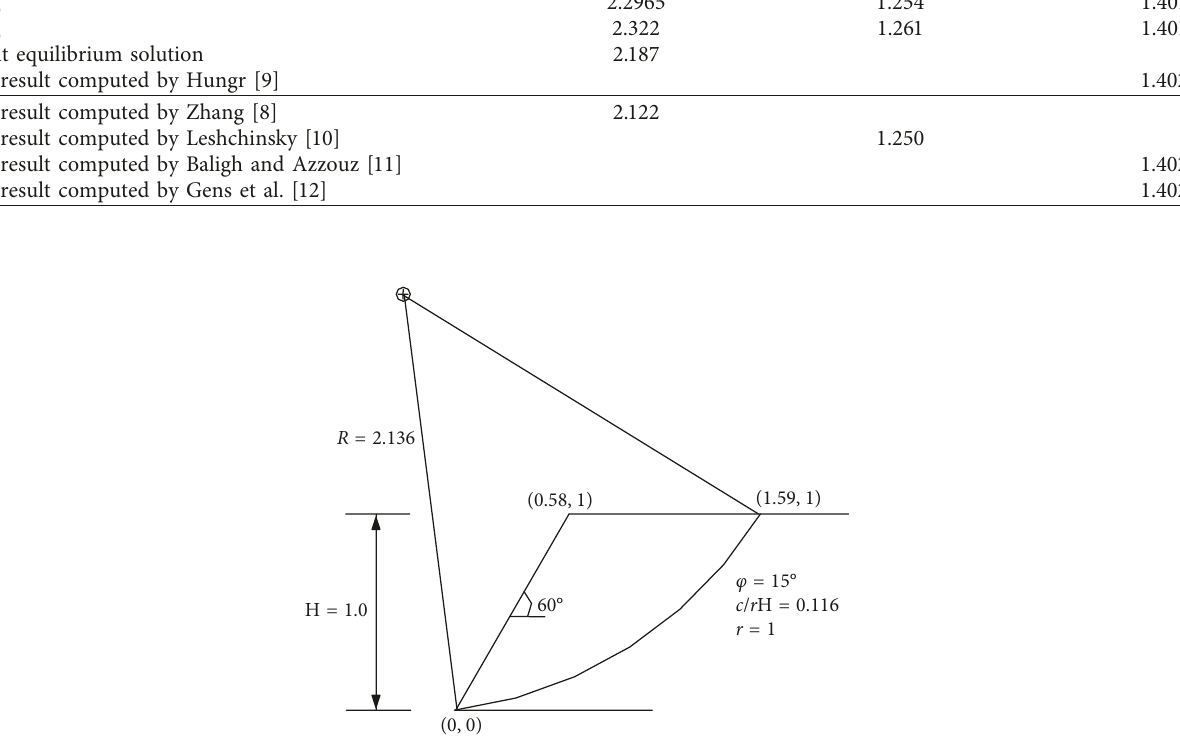
Figure 5: An ellipsoidal slip surface and parameters of a